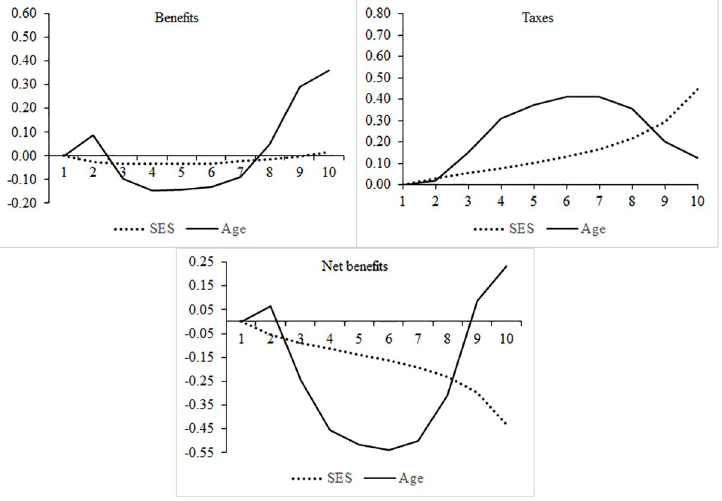
Fig 4. Average marginal effects of socio-economic status and age groups in the benefits, taxes, and net benefits models (reference category, age = 1 (youngest), SES = 1 (lowest)). Note: Based on regression models including only age and SES dummies and their interaction as explanatory